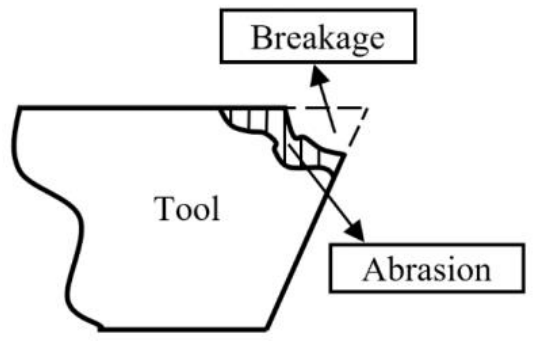
Figure 4. Schematic diagram of the abrasion and the